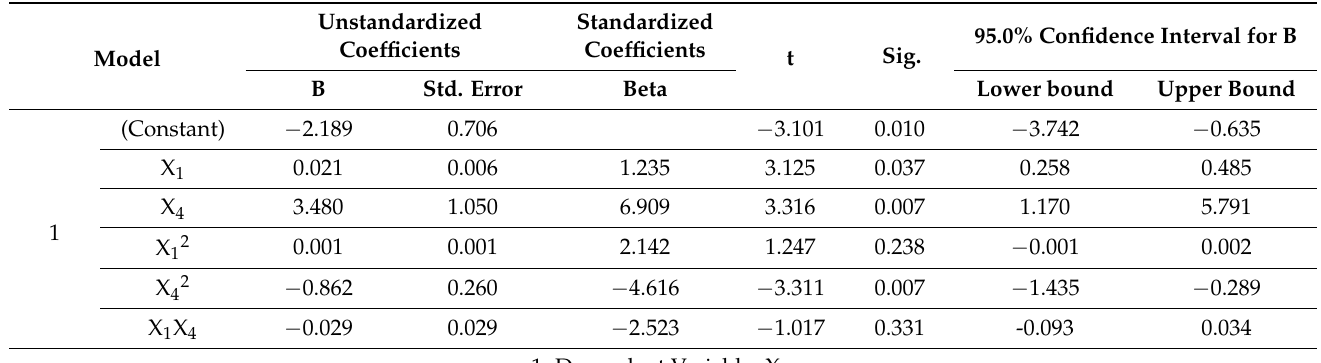
Table 17. Coefficients for 2nd order polynomial with two predictors.